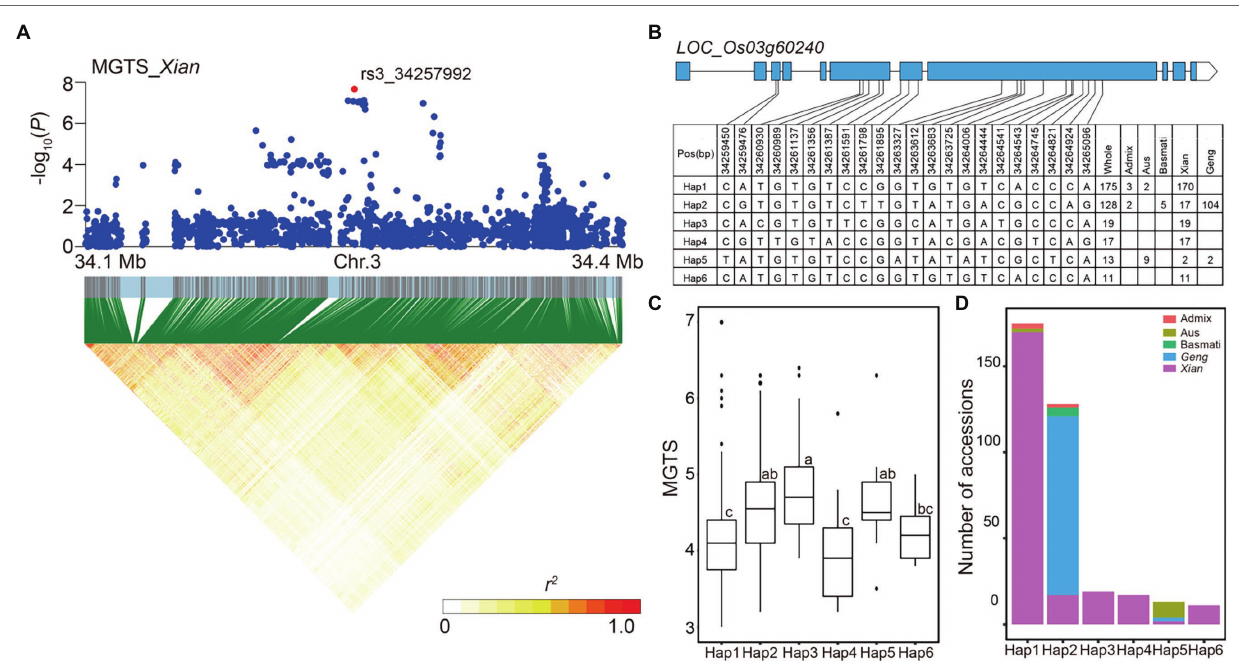
FIGURE 5 | Candidate gene analysis of locus 32 on chromosome 3. (A) Local Manhattan plot (top) and LD heat map (bottom) of locus 32 for MGTS in the Xian subpopulation. The red dot indicates the lead SNP rs3_34257992 and the position of candidate gene LOC_Os03g60240 . (B) CDS-haplotypes of LOC_ Os03g60240 . (C) The distribution of MGTS in the whole population for the six haplotypes of LOC_Os03g60240 . Different letters above each boxplot indicate significant differences among haplotypes according to Duncan’s multiple range post-hoc test ( p < 0.05). (D) Frequency of six haplotypes of LOC_Os03g60240 in